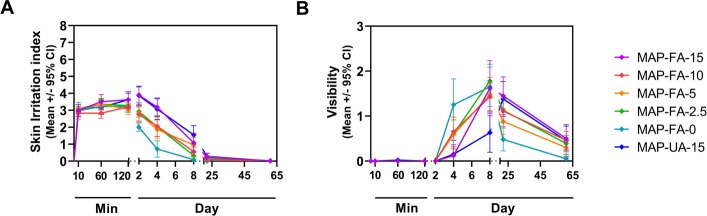
Time course of injection site reaction resolution.(A) SII, scale 0 to 8. (B) visibility (i.e., colouration at the application site), scale 0 to 3. Symbols represent mean scores ± 95% confidence intervals. Day, study day (HD-MAP applied on day 1); HD-MAP, high-density microarray patch; Min, minutes after HD-MAP application; SII, skin irritation index.